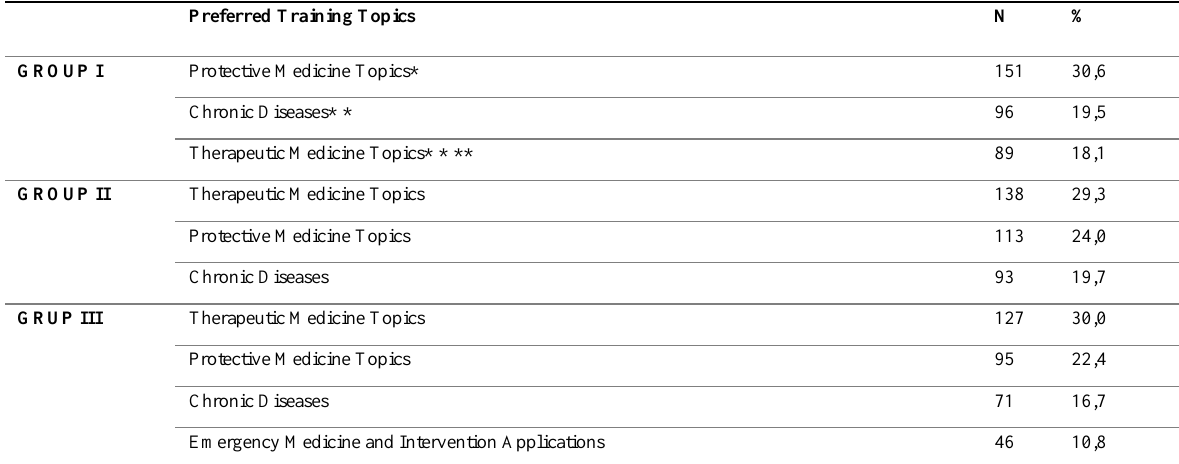
Table 15: Preferred Priority Training Subjects for Improving the Performance of